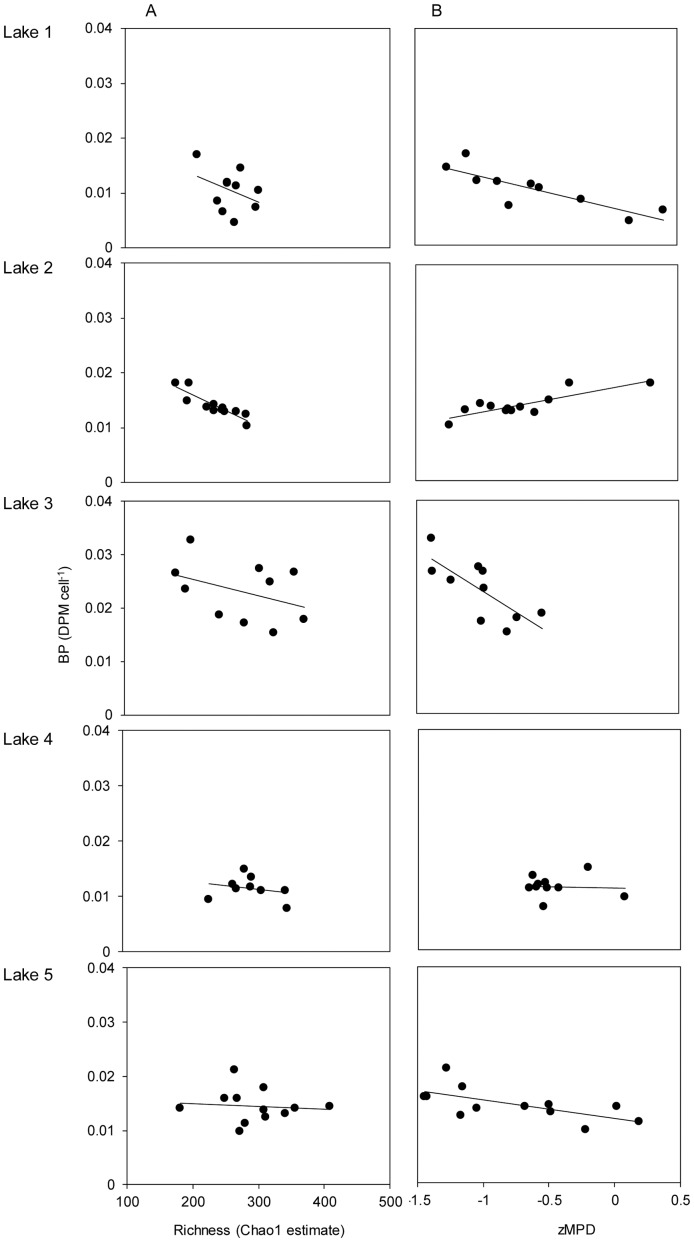
Associations between functioning and richness (A), and functioning and average phylogenetic distance (B).Community functioning is assessed as per cell bacterial production, local richness of the bacterial community estimated by Chao1 (A), and average phylogenetic distance between bacteria in a community estimated as standardized effect size of MPD (B).